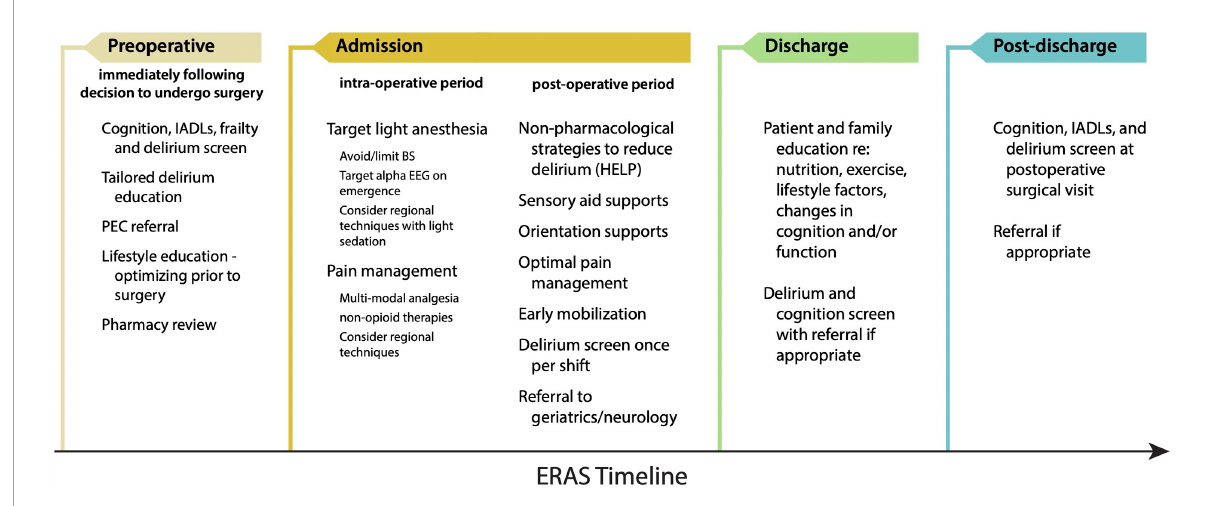
FIGURE3 Proposed Brain-ERAS pathway for the prevention and mitigation of PND. HELP, Hospital Elder Life Program; IADL, instrumental activity of daily living; PEC, pre-anesthesia evaluation